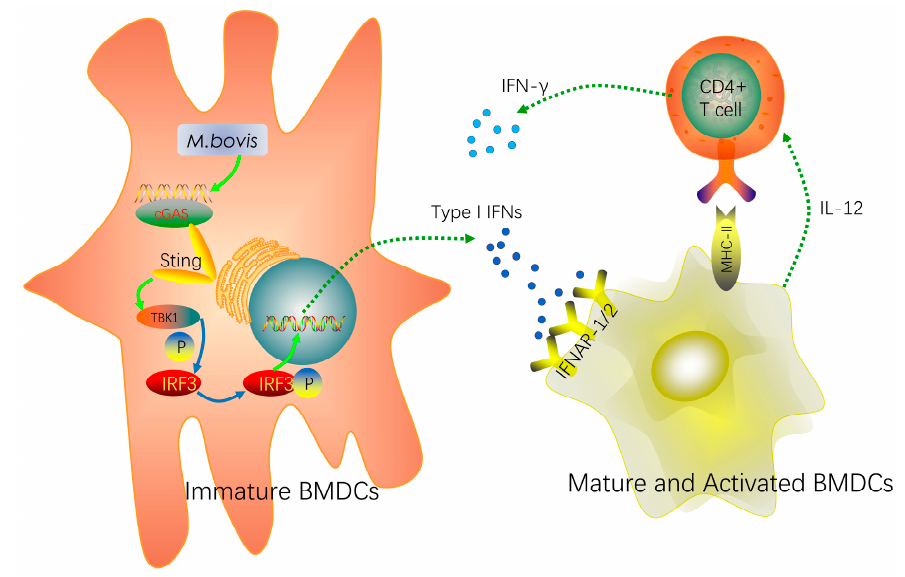
Figure 5. Mediation of the maturation and activation of BMDCs during Mycobacterium bovis infection by the cGAS pathway. Mycobacterium bovis regulated the maturation and activation of BMDCs via the cGAS/STING/TBK1/IRF3-dependent pathway and promoted type I IFN production. Furthermore, type I IFN and its receptor IFNAR contributed to this process. Moreover, the mature and activated BMDCs enhanced the proliferation of T cells by some surface markers and cytokines. These signaling pathways linked the innate and adaptive immune responses. (The full line arrows signify promotion; the dotted arrows signify releasing cytokines.)